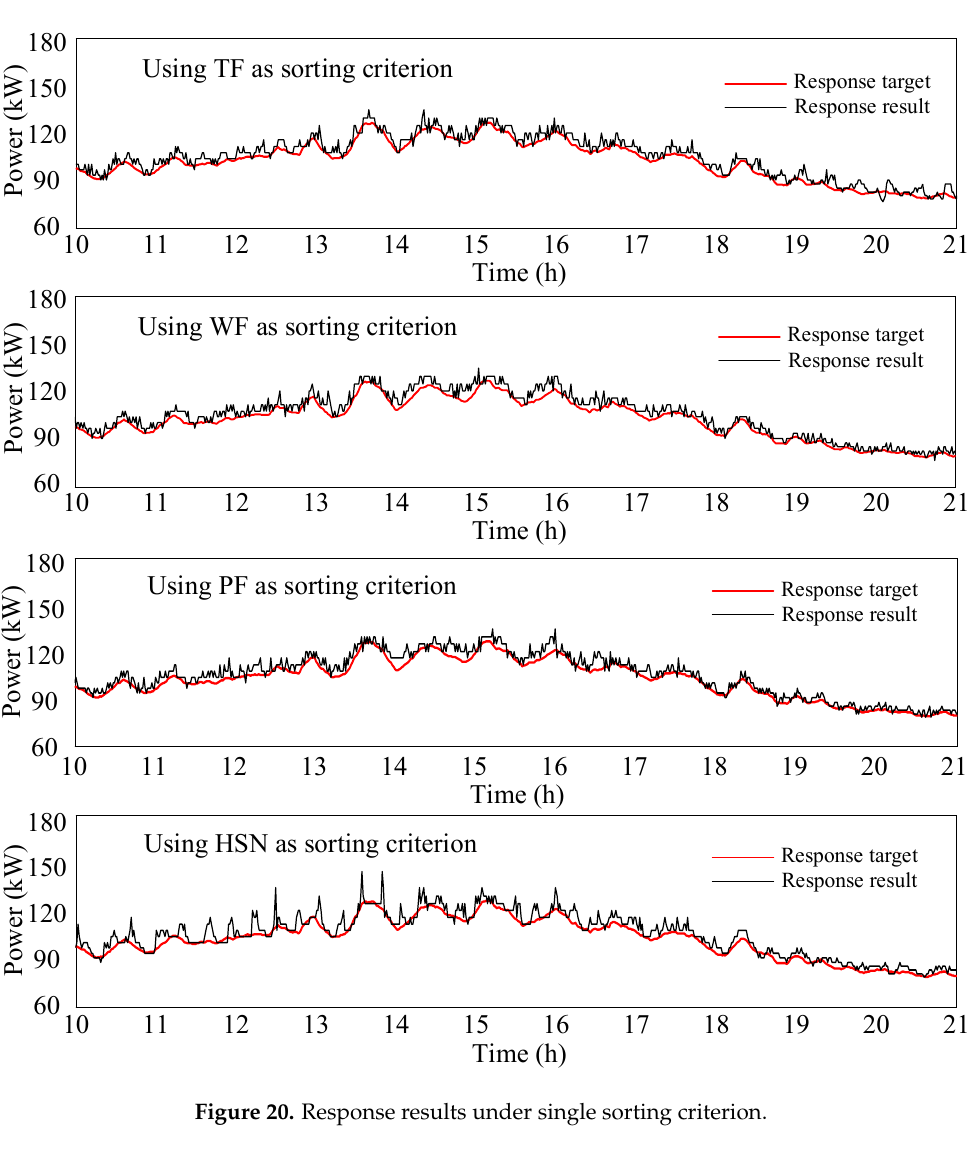
Figure 20. Response results under single sorting criterion. Energies 2017 , 10 , 2133